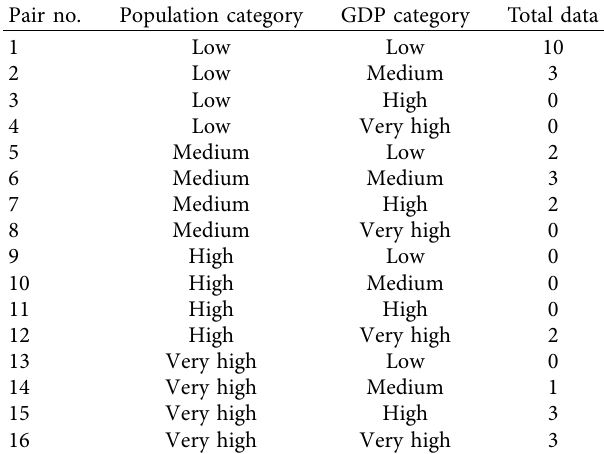
Table 7: Pair categories on the variable population size and GDP to test the relationship between the public acceptance level of the two variables